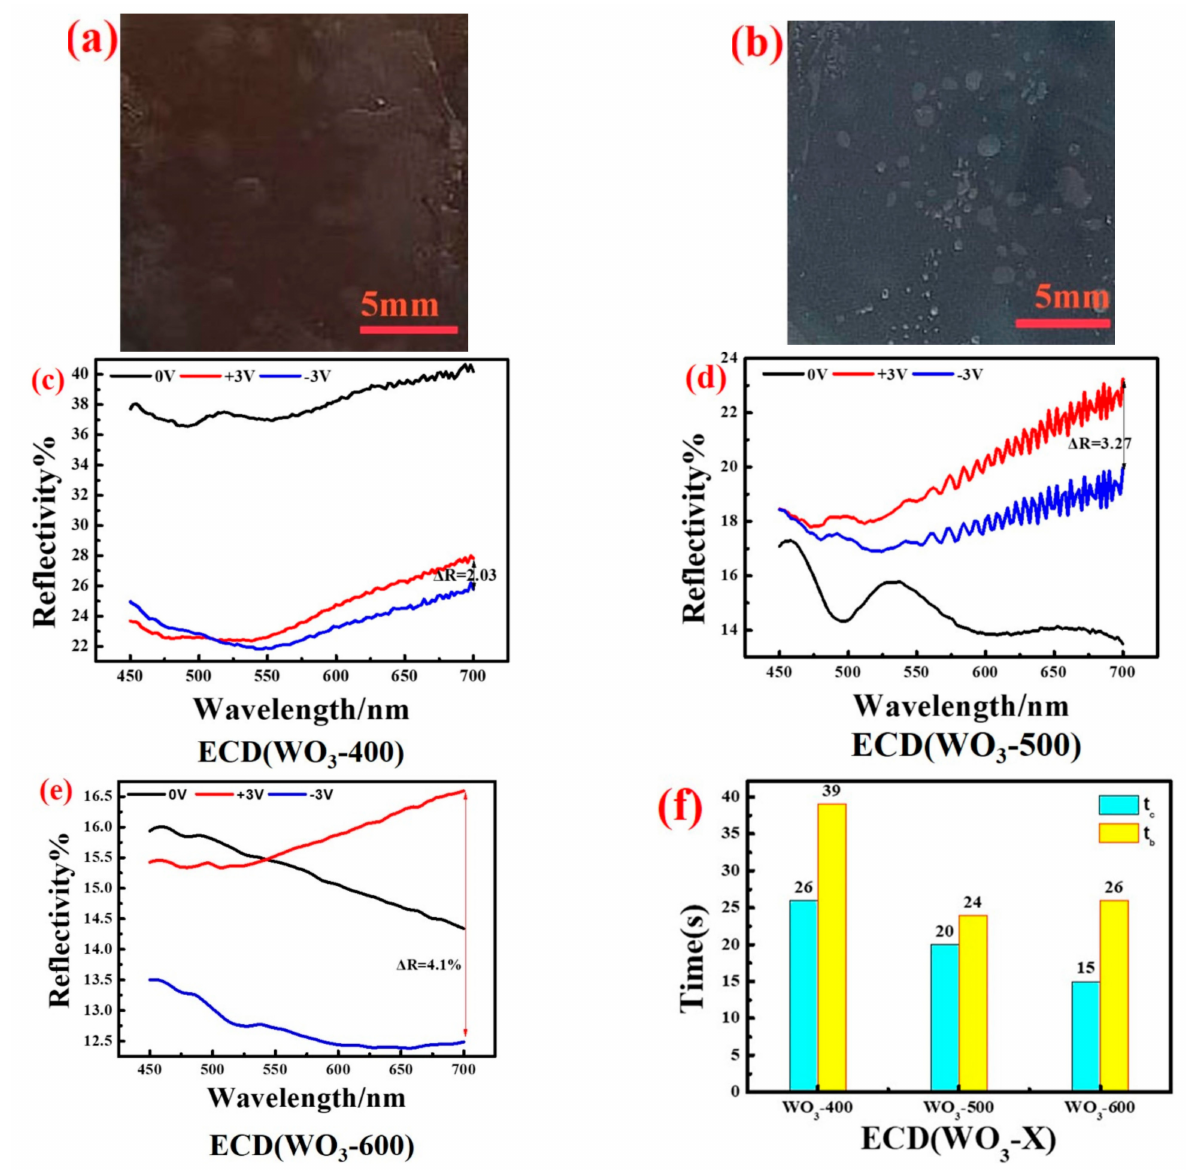
Figure 2. ( a ) Photo of the colored state of the electrochromic device; ( b ) Photo of the bleached state of the electrochromic device; ( c ) ECD reflectance spectrum of WO 3 -400 under different voltage conditions; ( d ) ECD reflectance spectrum of WO 3 -500 under different voltage conditions; ( e ) ECD reflectance spectrum of WO 3 -600 under different voltage conditions; ( f ) Coloring and bleaching time of ECD (WO 3